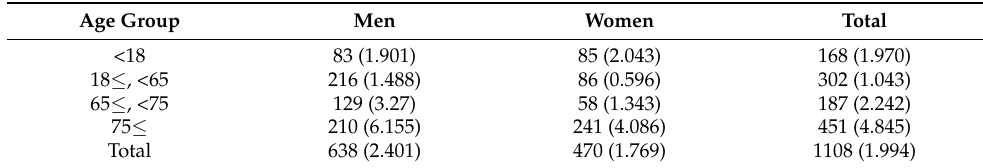
Table 3. Number of heat stroke cases (2017–2019).